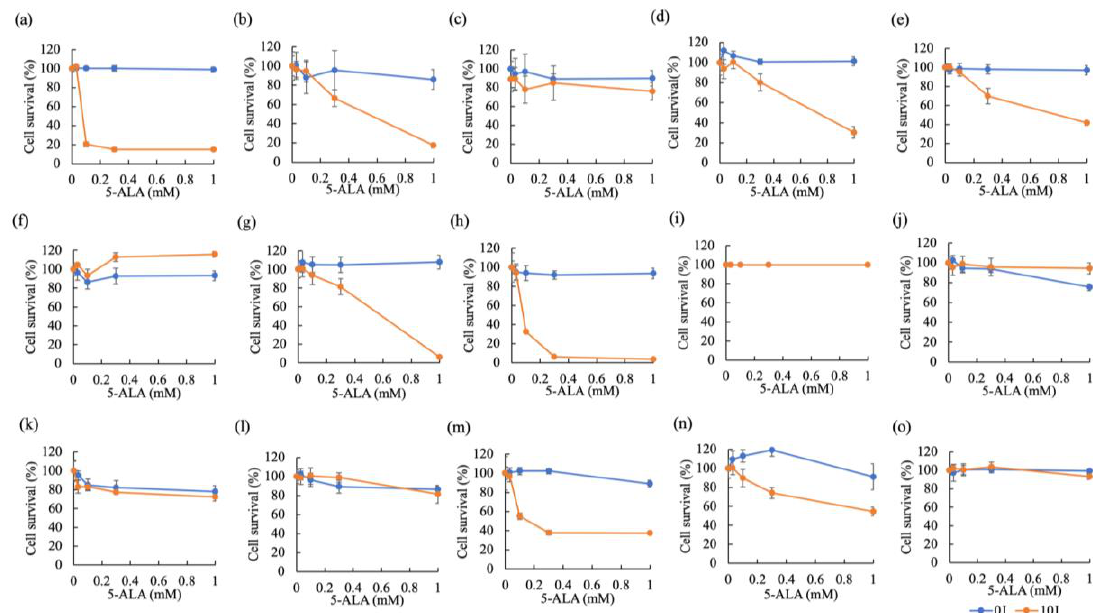
Figure 7. Cytotoxicity of 5-ALA-photodynamic therapy (PDT). A total of 15 primary tumor cell lines (Carcinomas: ( a ) IUT, ( b ) Jack, ( c ) Gal, ( d ) YDP, ( e ) HDC, ( f ) LuBi, ( g ) JDM, ( h ) FBC, and ( i ) SNP; Sarcomas: ( j ) SGR, ( k ) KLC, ( l ) DML, ( m ) YCC, ( n ) ITP, and ( o ) HTR) were incubated with different concentrations of ALA (0, 0.03, 0.1, 0.3, 1 mM) and irradiated for 0 or 500 s. Cell viability was examined using Cell Counting Kit 8 (Dojindo Molecular Technologies, Inc., Kumamoto, Japan). Data are expressed as the means ± S.D. ( n = 6).